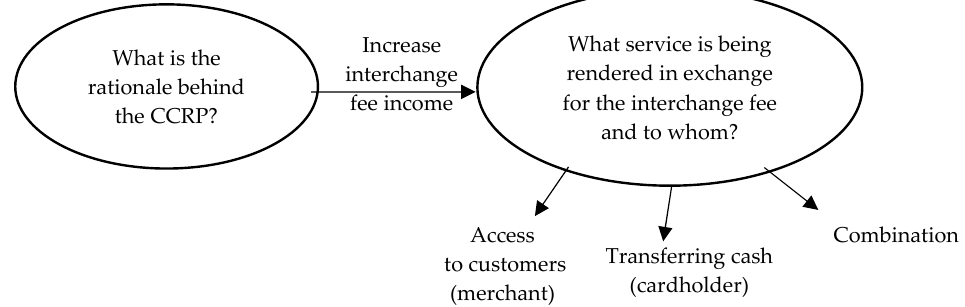
Figure 5. Rationale behind the CCRP is an increase in interchange fee income, considering the customer in relation to the card issuer.